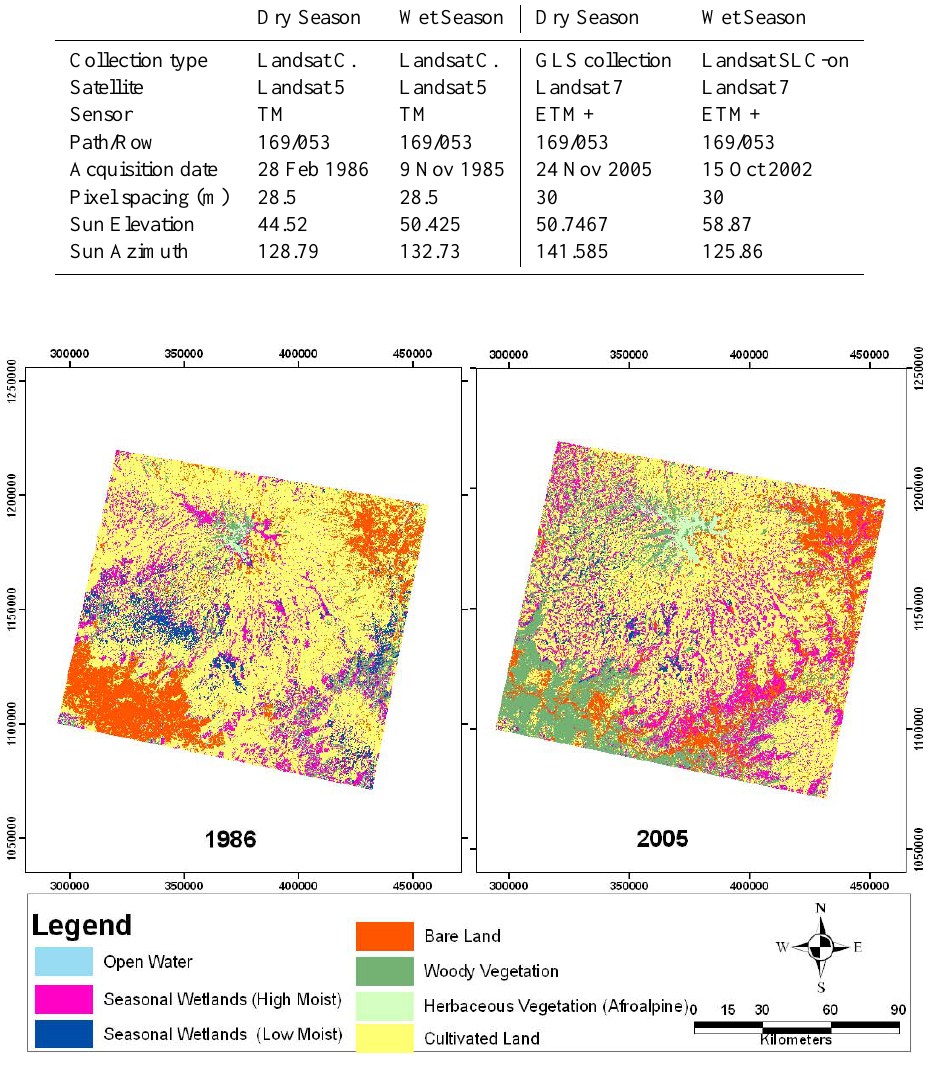
Fig. 2. Land covers in 1986 and